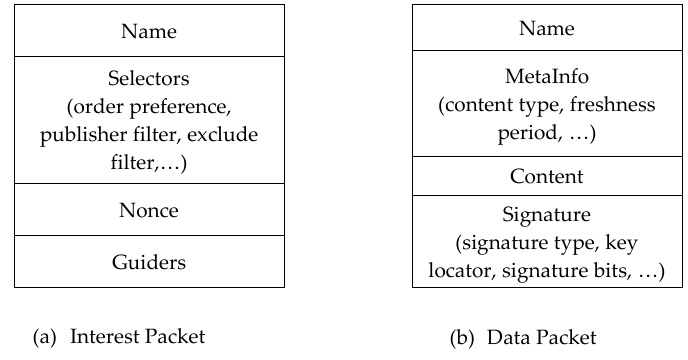
Figure 1. Named Data Networking (NDN) Packets (reproduced according to “Name Data Networking”)